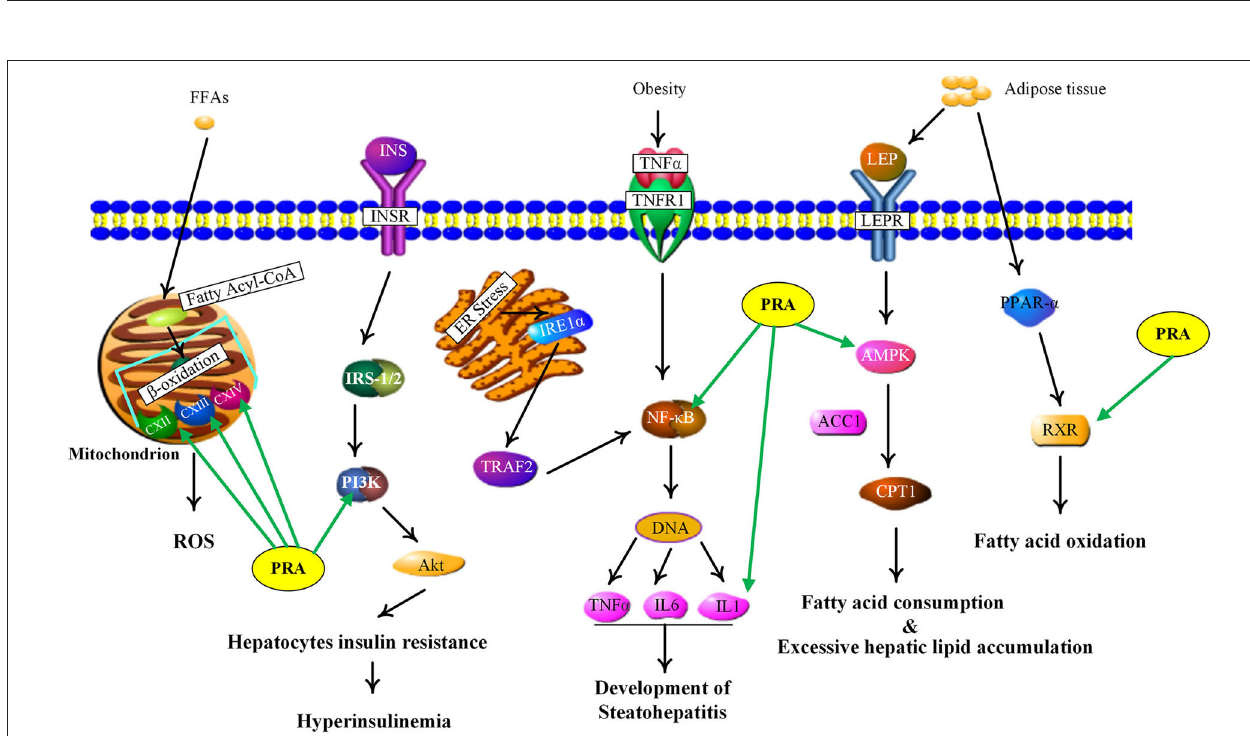
FIGURE 4 | PRA key components-major hubs–main pathways network. Green diamonds represent each component (prototype/metabolite) in PRA; round pink nodes represent putative targets of PRA components; round red nodes represent known therapeutic targets for HP; round yellow nodes represent both putative targets of PRA components and known therapeutic targets for HP, and targets circled in blue represent those important hubs involved in the progression of PRA acting on HP; blue rectangles represent top 10 pathways from enrichment analysis of major targets, and blue rectangle circled in red represent the most significant pathway; edges represent interactions among PRA key components, putative targets, known therapeutic targets for the treatment of HP, and main pathways.